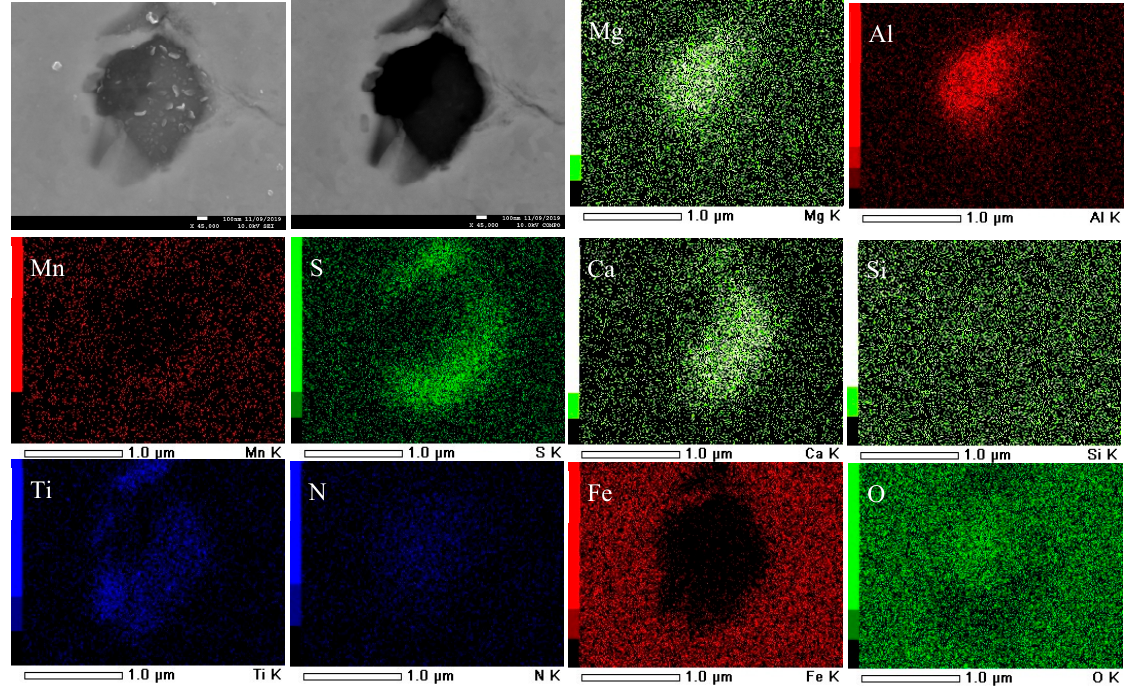
Figure 13. The element distribution of typical multiphase inclusion.